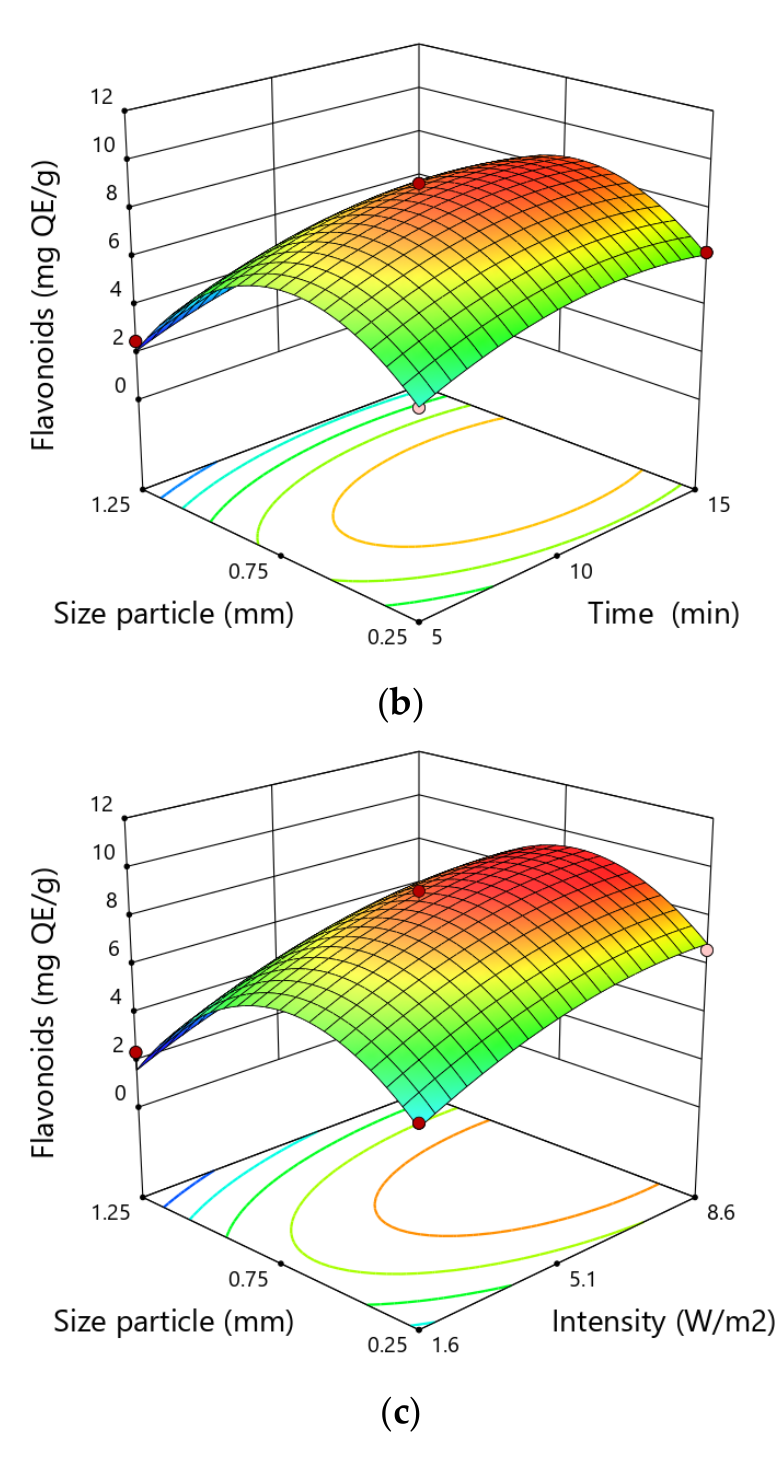
Figure 2. Response surfaces obtained with the Box–Behnken experimental design for the total flavonoid content (mg QE · g − 1 ) in hemp depending on the ( a ) intensity and time, ( b ) particle size and time, and ( c ) particle size and intensity. Based on the obtained results, the effects of the independent variables on the depen- dent variables are presented in Table